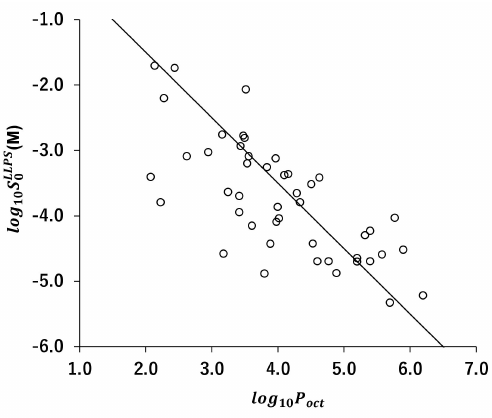
= 0.5 − log 10 P oct . 0